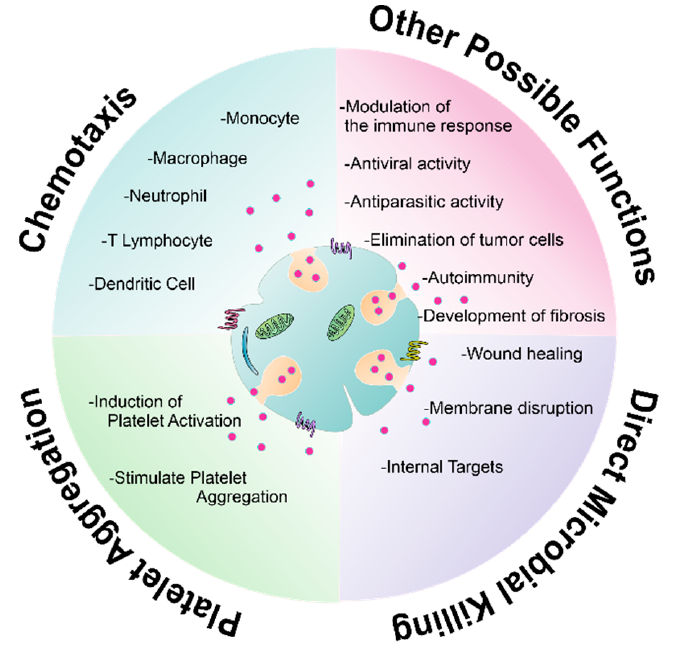
Figure 5. Functions described and probably exerted by antimicrobial molecules present in human platelets. Platelet-derived kinocidins and CHDPs participate in various scenarios, such as the direct microorganism killing, platelet activation and aggregation, and immune cells chemotaxis. Nevertheless, new contexts for and participation of platelet-derived antimicrobial molecules should be extensively explored, e.g., immunomodulation, antiviral and anticancer activity, among a plethora of potential functions.